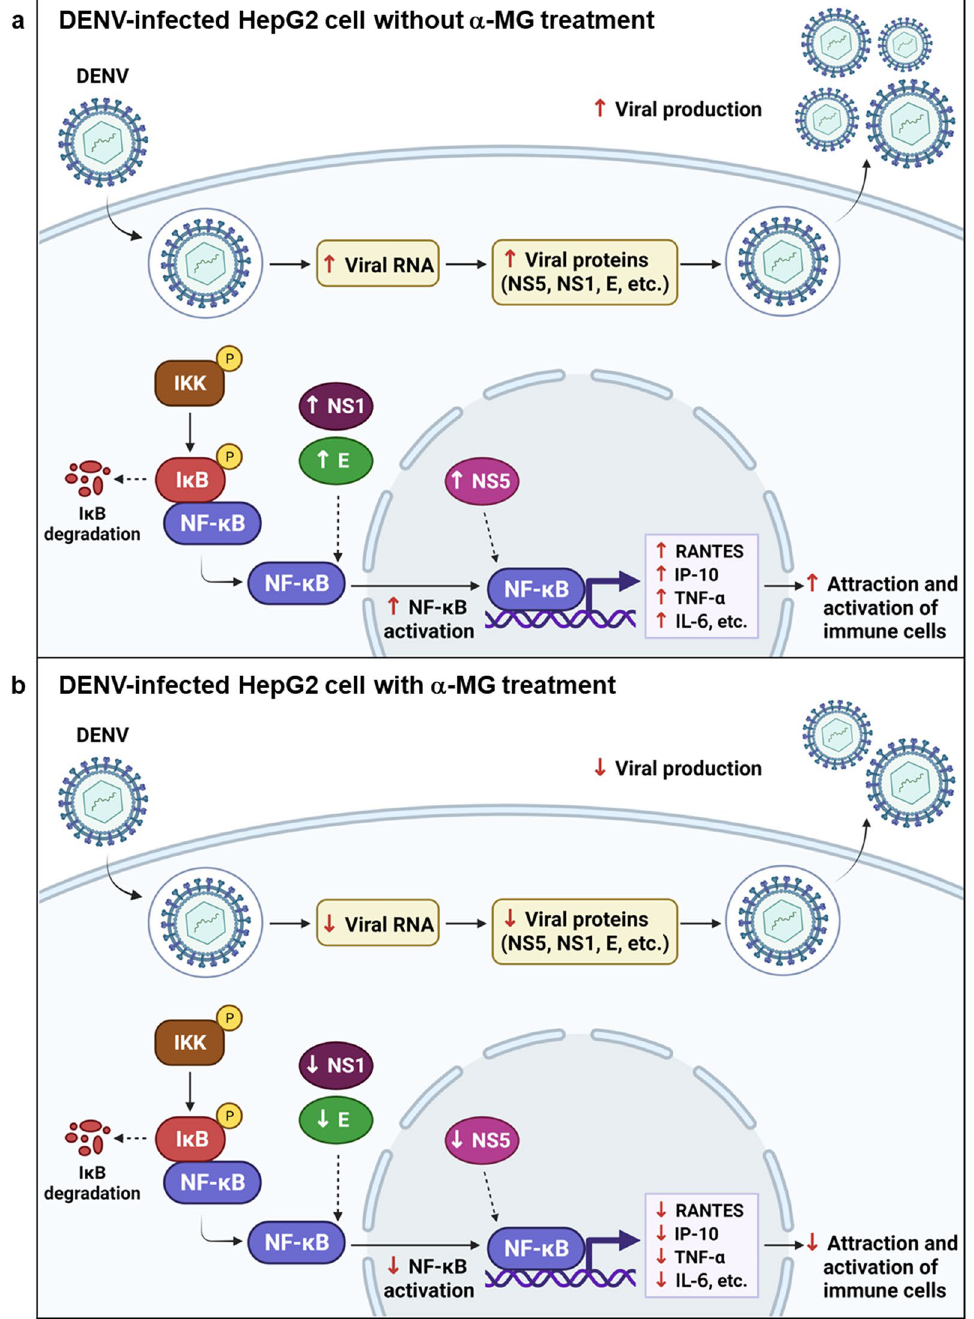
Figure 8. Proposed model for inhibition of dengue virus (DENV) and cytokine/chemokine production by